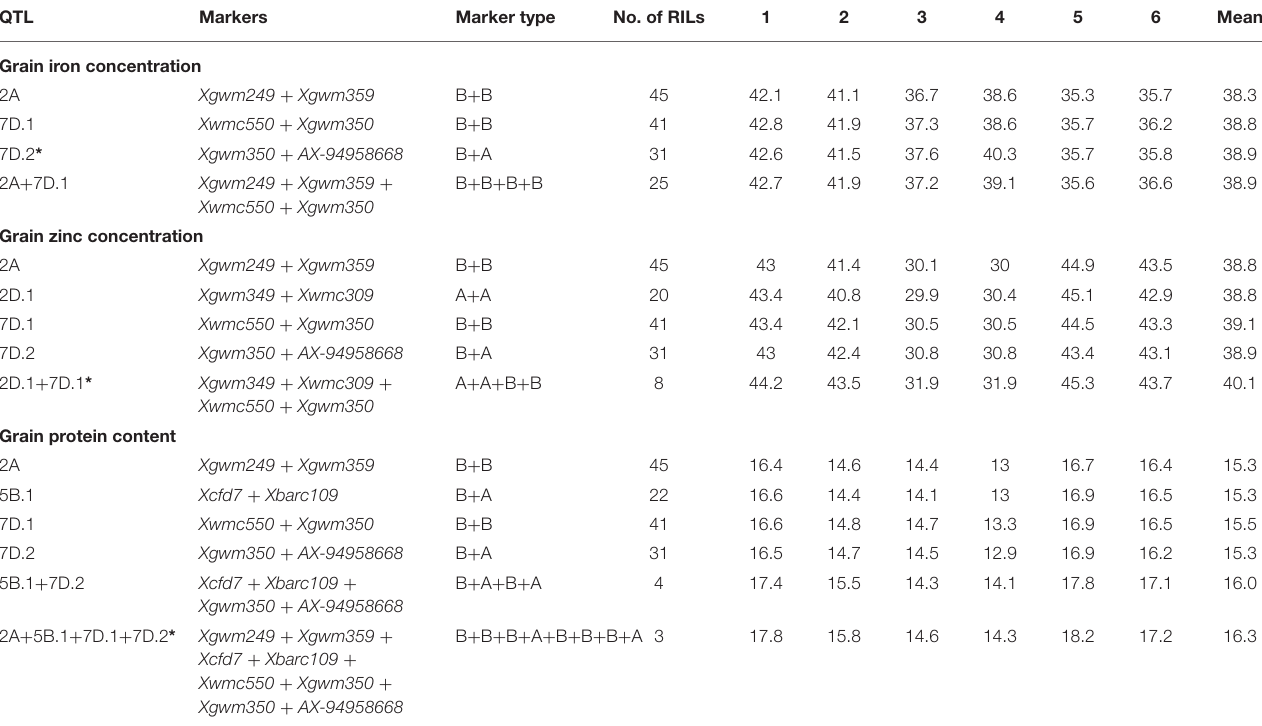
TABLE 5 | RILs with best combination of QTL for biofortification traits in wheat. QTL Markers Marker type No. of RILs